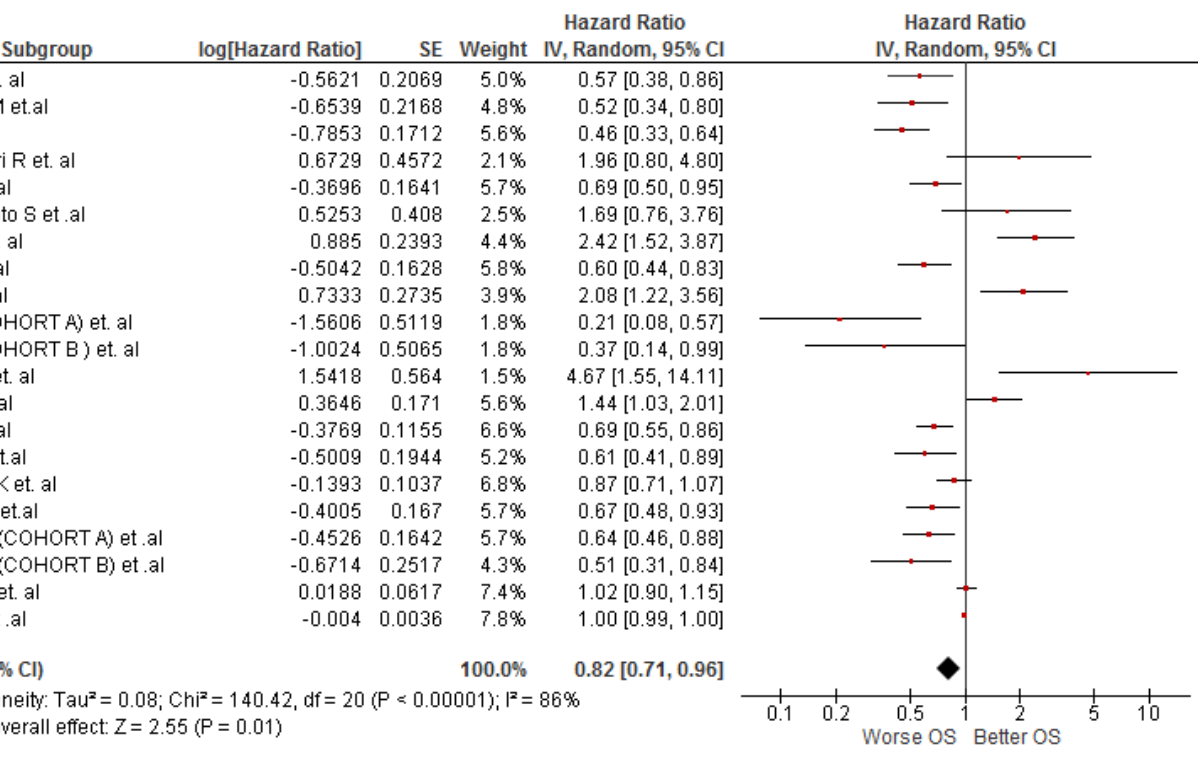
Figure 2. Association of LMR and OS in patients with cholangiocarcinoma.